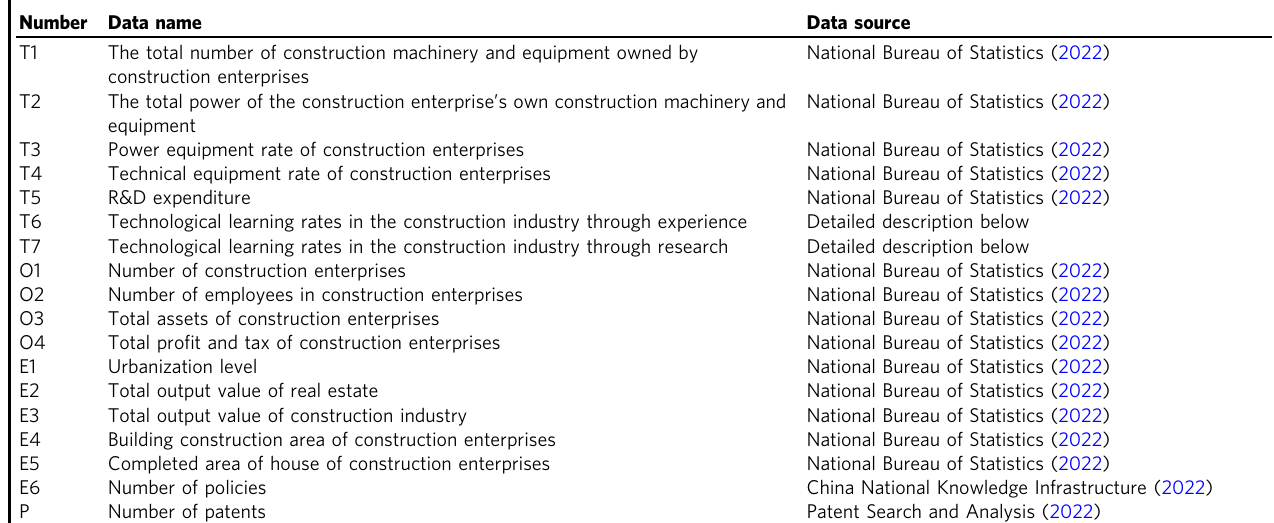
Table 3 Data source